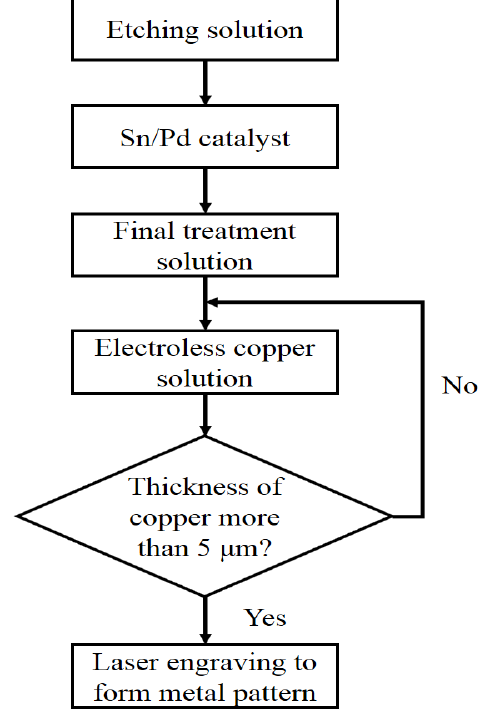
Figure 4. The detailed steps of the low-temperature metallization process.